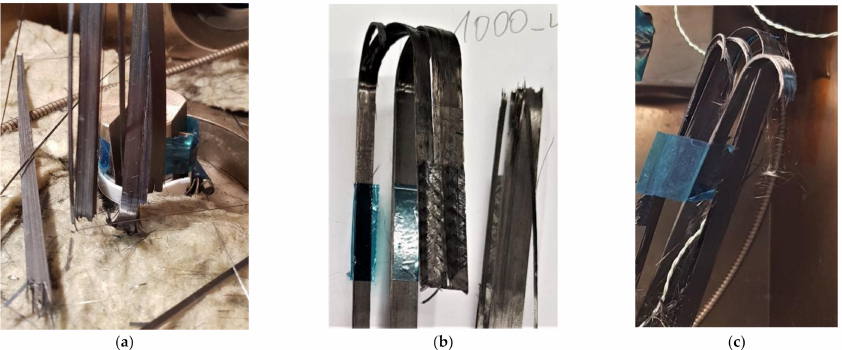
Figure 21. Failure mode of the straps in fatigue tests at a service temperature of 60 ◦ C at ( a ) 1000 Mpa USL, ( b ) between 1150-1300 Mpa USL, and ( c ) at 1400 Mpa